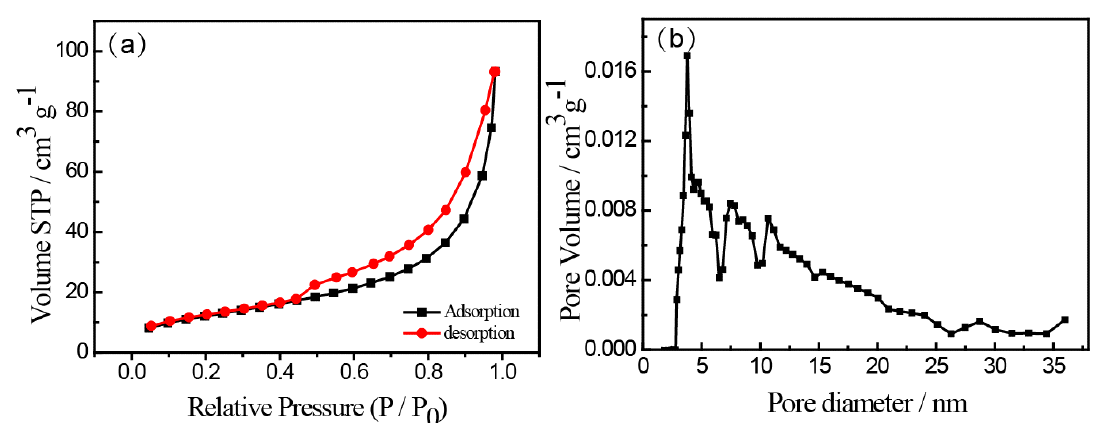
Figure 4. ( a ) N 2 adsorption/desorption isotherms of Co@CNTs-800; ( b ) Pore size distribution curves of Co@CNTs800.